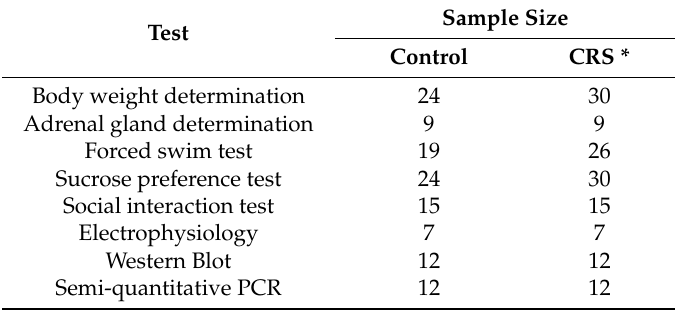
Table 3. Sample-size per